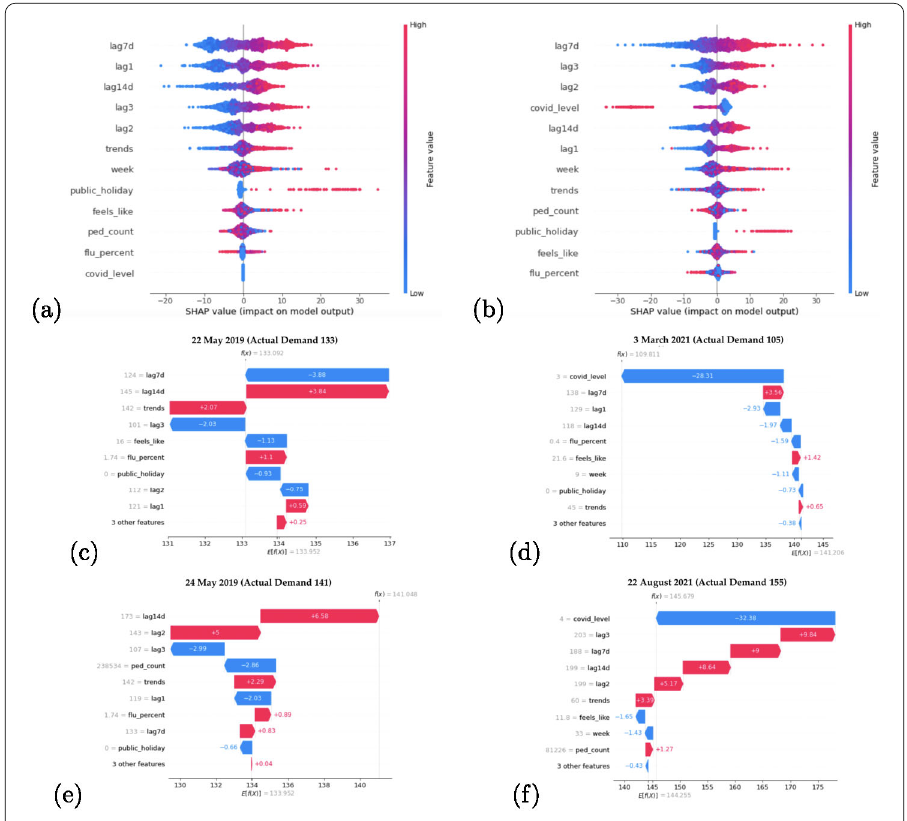
Figure 8 SHAP graphs for 2019 (Left) and 2021 (Right) models. ( a ) and ( b ) depict feature importance summary plots. ( c )–( f ) show explanations of forecasts for specific dates together with the observed